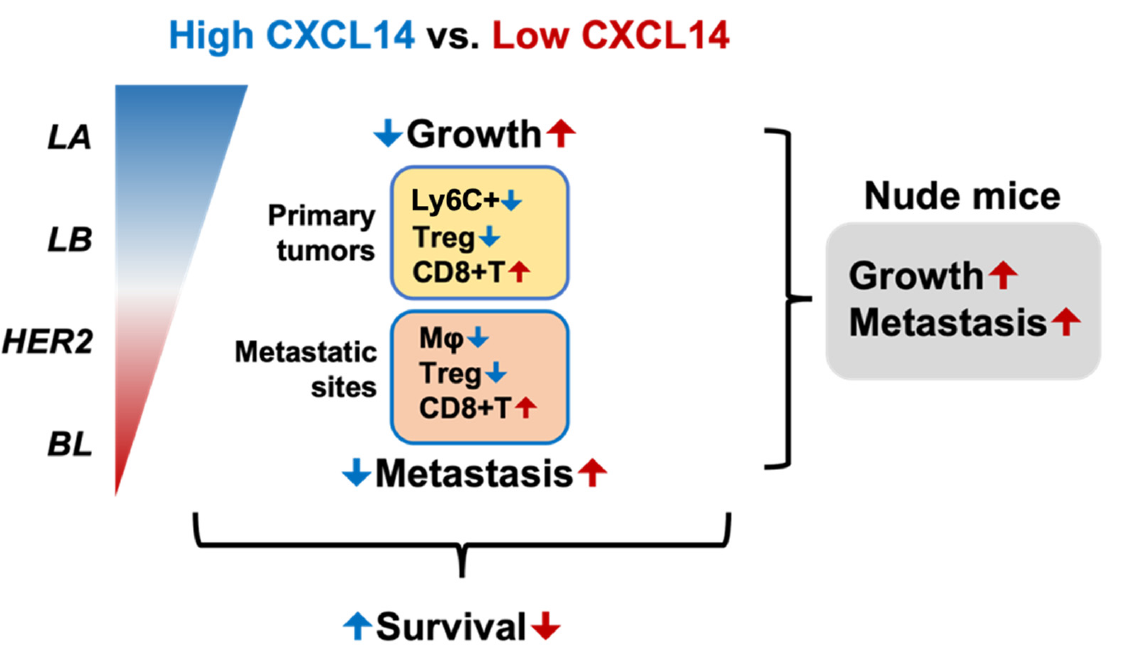
Figure 7. Schematic presentation of CXCL14-induced reduction of TNBC progression. Basal-like (BL) subtype including TNBC has the lowest levels of CXCL14 compared to other subtypes, such as luminal A (LA), luminal B (LB), and HER2. High levels of CXCL14 correlate with improved survival in breast-cancer patients. High levels of CXCL14 reduce tumor growth and metastasis by modulating immune profiles as follows: decreased Ly6C+ myeloid cells (Ly6C+) and Treg infiltration, and increased CD8+ T cell infiltration in primary tumors; decreased macrophages (M ϕ ) and Treg infiltration and increased CD8+ T cell infiltration in metastatic lungs. T cell deficient condition blocks CXCL14-induced reduction of TNBC progression. Based on these results, we concluded that CXCL14 attenuates TNBC progression by regulating immune-cell profiles of the tumor microenvironment in a T cell-dependent manner. Blue and red letters in primary tumors and metastatic sites indicate decrease and increase in immune cell infiltration,